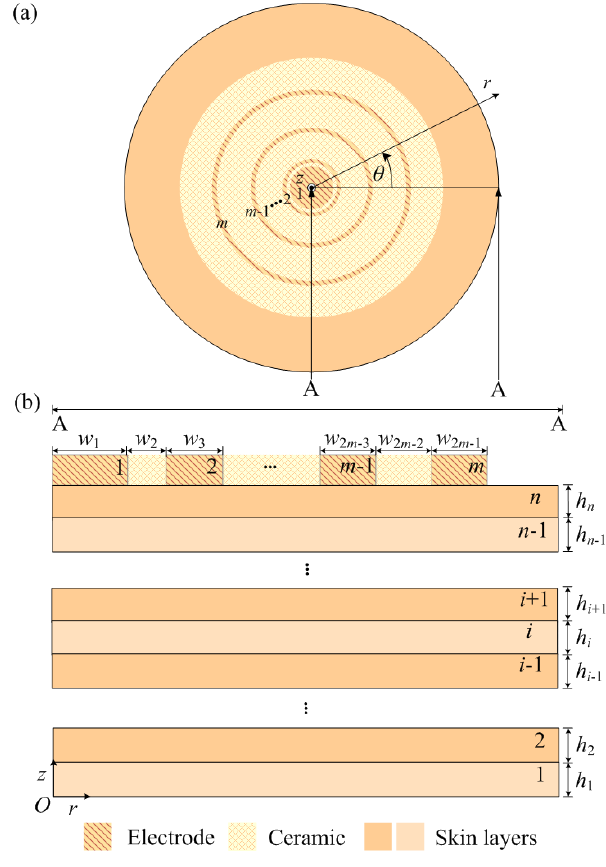
Fig.2: Schematic of skin comprising n layers and a circular EIS probe with m